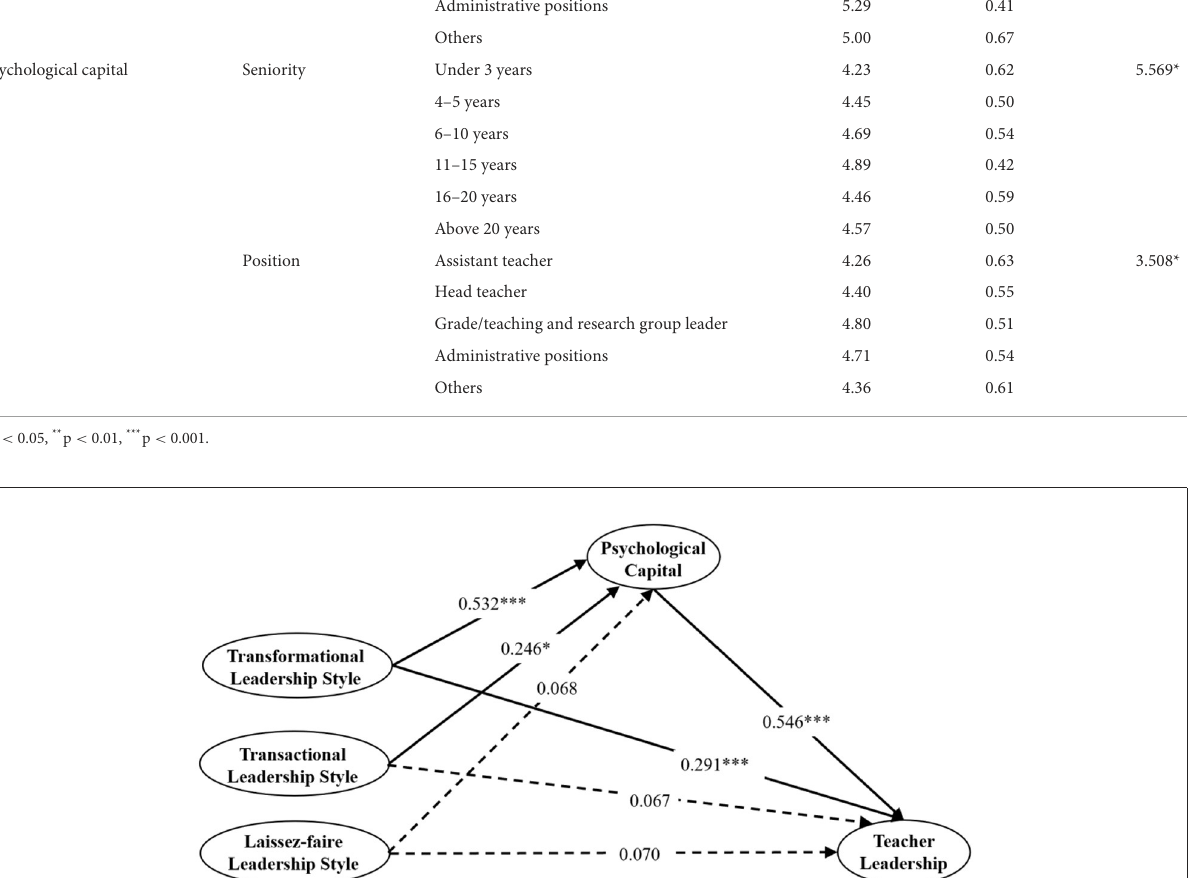
df = 2332, RMSEA = 0.073, CFI = 0.905, TLI = 0.918,